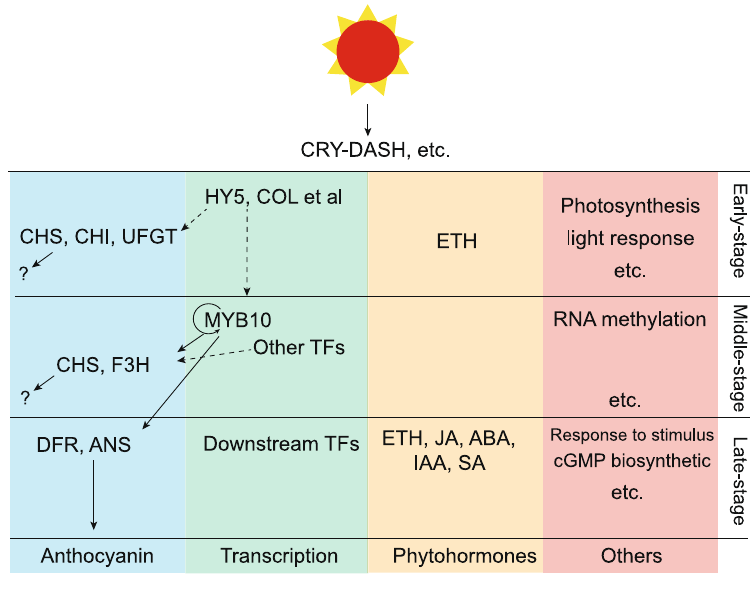
Figure 9. Putative model for bag removal-induced anthocyanin biosynthesis in ‘Meirensu’ pear peels. The phytohormone and other pathways based on the gene ontology enrichment